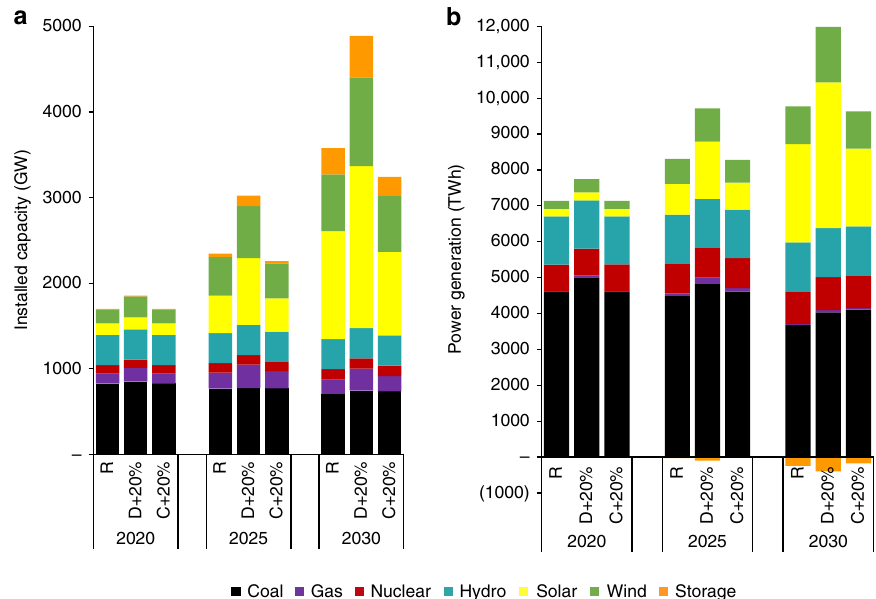
Fig. 8 Sensitivity analyses of 2030 capacity and generation mixes under the D + 20% and C + 20% scenarios. a installed capacity mix. b power generation mix. D + 20% assumes that demand increases linearly 20% until 2030; C + 20% assumes that the capital costs of solar, wind, and storage are 20% higher than under the R scenario. Source data are provided as a Source Data fi